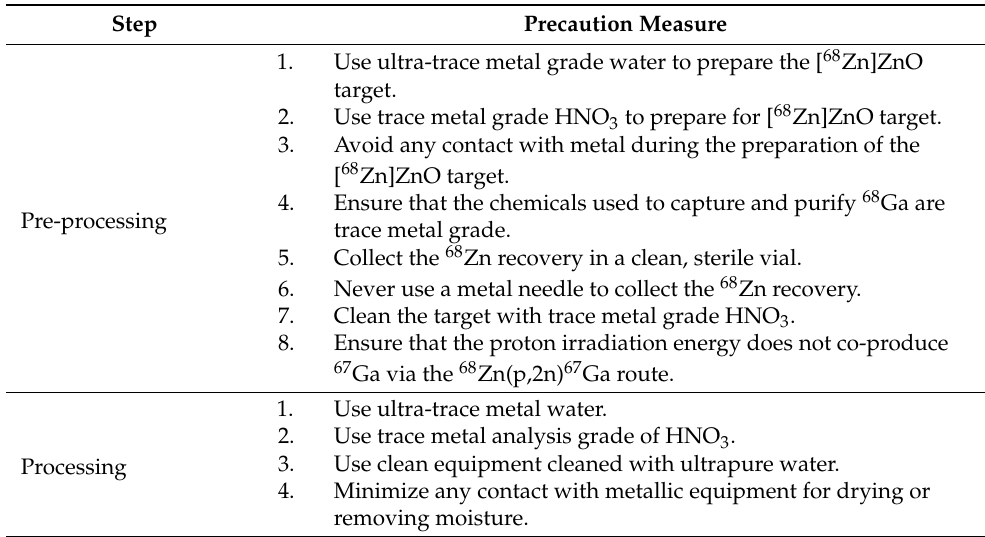
Table 10. Precaution measures to be considered for [ 68 Zn]ZnO